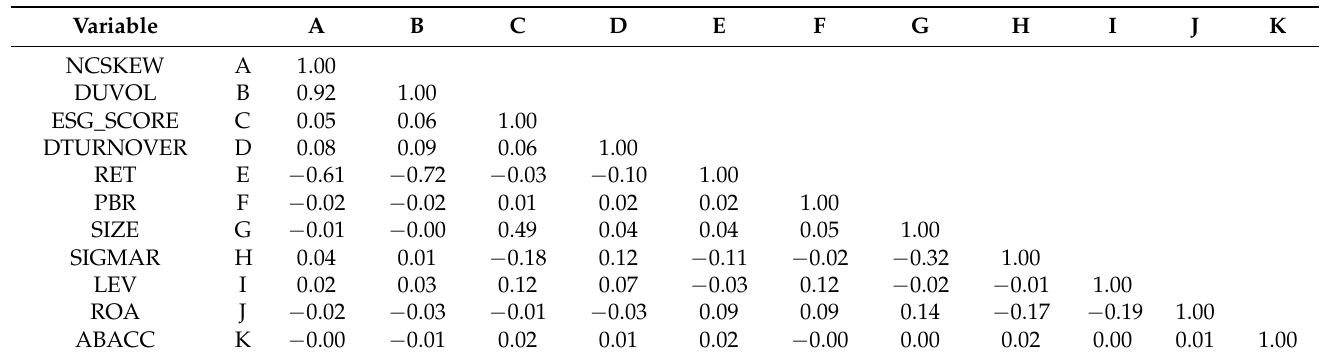
Table A2. Correlation Matrix for S&P 500 members.